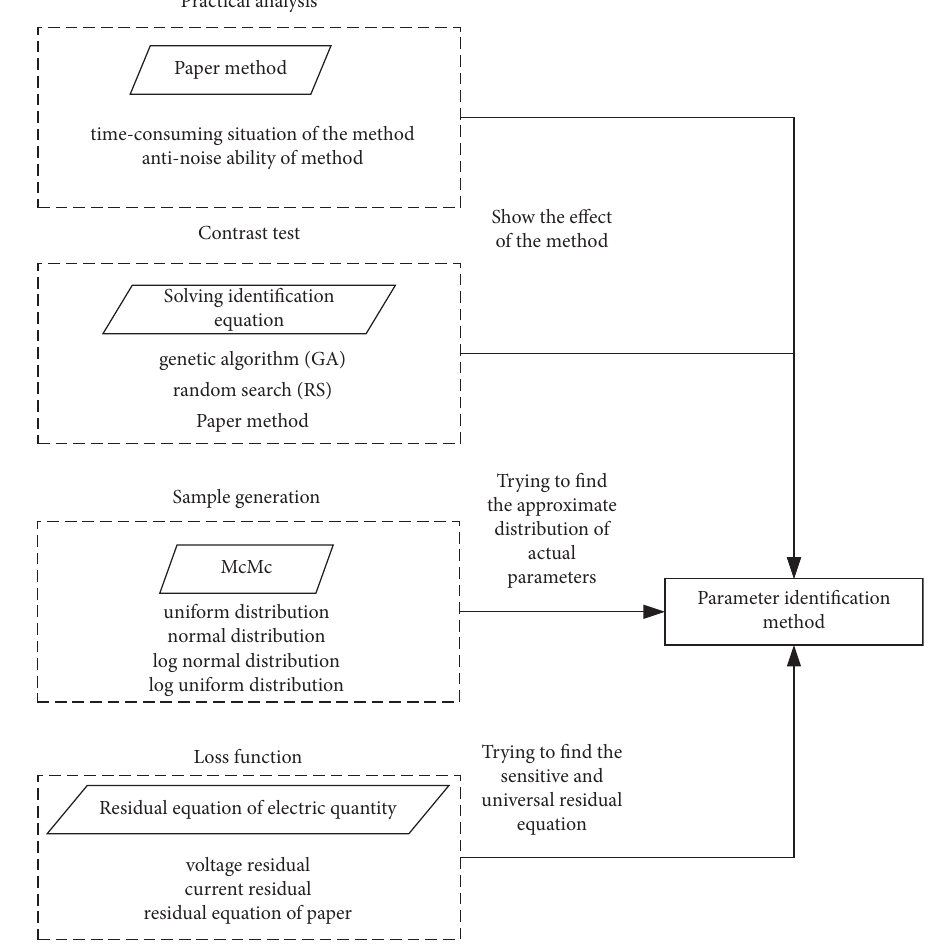
Figure 4: Te schematic diagram of this study’s experiment.